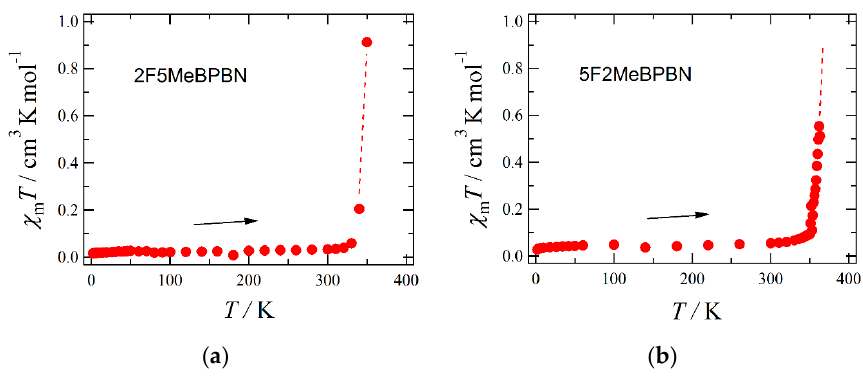
Figure 7. Temperature dependence of χ m T for ( a ) 2F5Me- and ( b ) 5F2MeBPBN, measured at 5000 Oe on heating from 2 to 350 and 360 K, respectively. Dotted lines are shown for a guide to the eye.